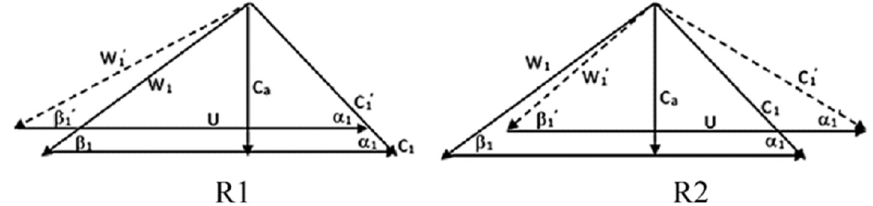
Figure 18. Velocity triangular change at inlet of R1 and